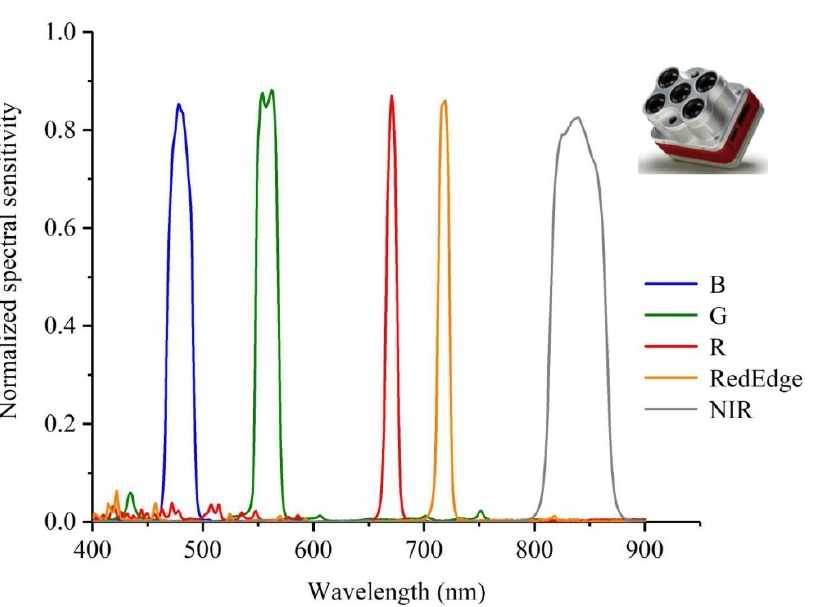
Figure 2. Spectral response curves of MicaSense Altum.